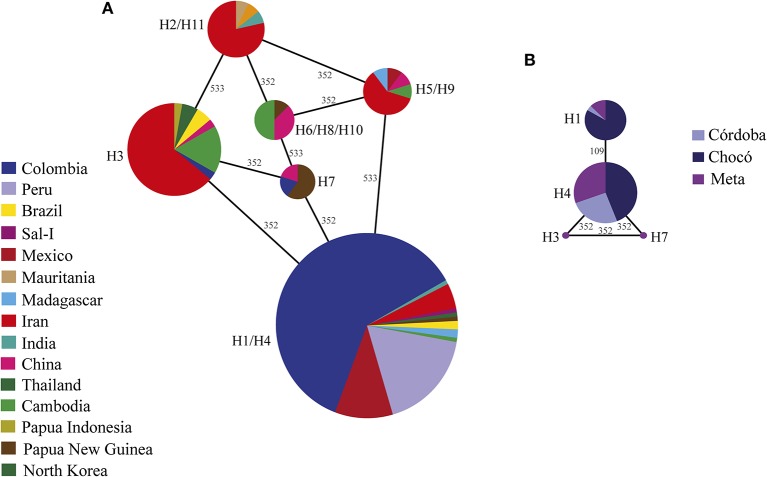
Haplotype networks. A haplotype network was created by the Median-Joining method using the 209 available sequences (A) and another for just Colombian sequences (n = 85) (B) to represent the relationships amongst the different haploid genotypes observed in the dataset. A haplotypes H1 and H4 were contracted within the same haplotype (H1/H4, they had the same aa sequences) whilst the haplotypes represented by just one sequence (H6, H8, and H10) were contracted together with haplotypes having high frequency and similar sequences. Circle size represents haplotype frequency whilst different colors indicate the sequences' geographical origin. The branches (lines) connecting haplotypes represent the mutational steps where the numbers on branches indicate the position where a nucleotide became changed for another one.